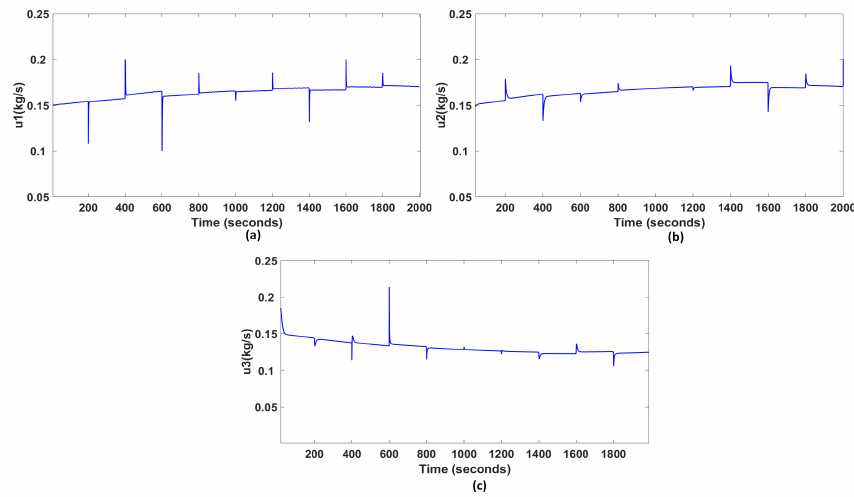
Figure 14. Control efforts,: ( a ) u 1 , ( b ) u 2 and ( c ) u 3 by the PID controller for the combination of steps reference (Zone 1 and Zone 2).